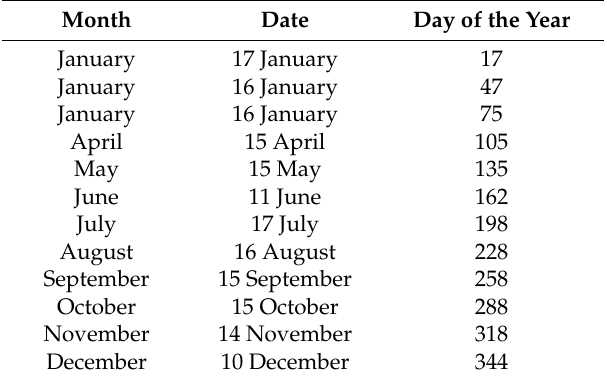
Table 9. Average day for each month as recommended by Klein